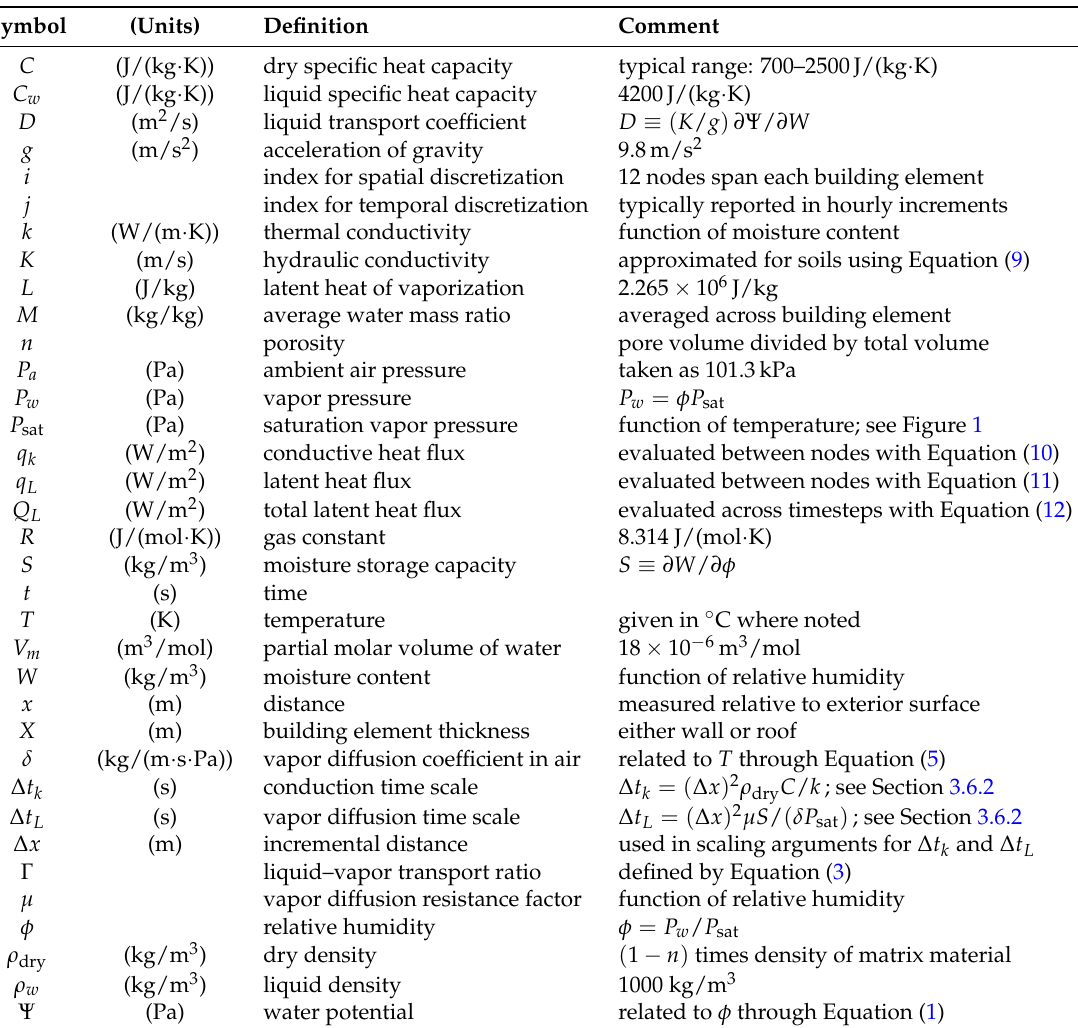
Table 1. Nomenclature used for modeling and values for physical